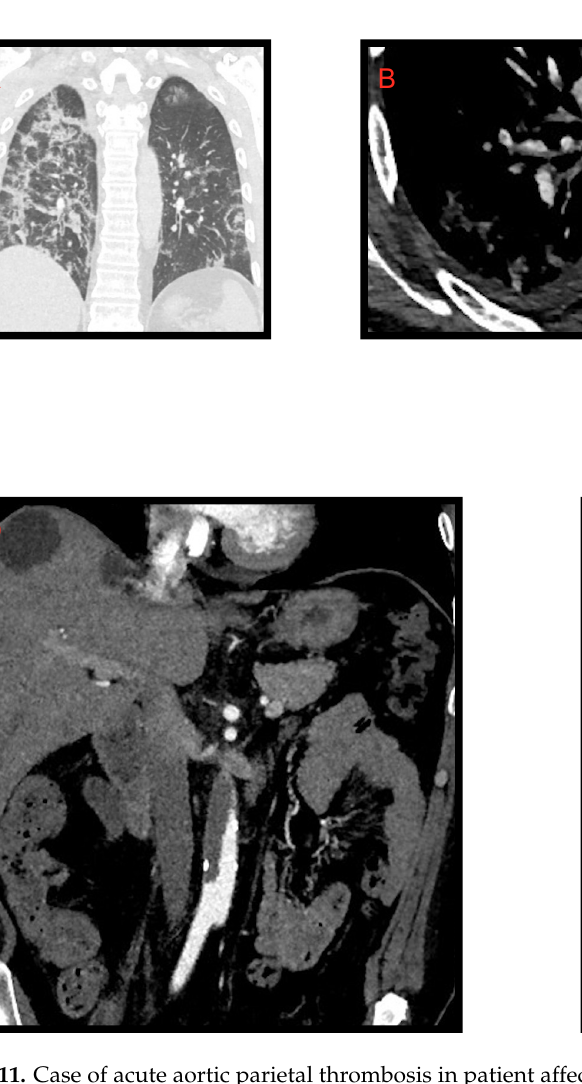
Figure 11. Case of acute aortic parietal thrombosis in patient affected by SARS-CoV-2 pneumonia. Image ( A ) shows the lung’s involvement caused by COVID-19 pneumonia. Thromboembolic opacification defect of a segmental (anterior) arterial branch for the right lower lobe is associated ( B ). ( C ) Axial images of subrenal acute aortic thrombosis. In coronal image ( D ) is it possible to notice the acute aortic thrombosis which extends craniocaudally for about 6 cm. ( E ) Complete resolution of aortic thrombosis after therapy.